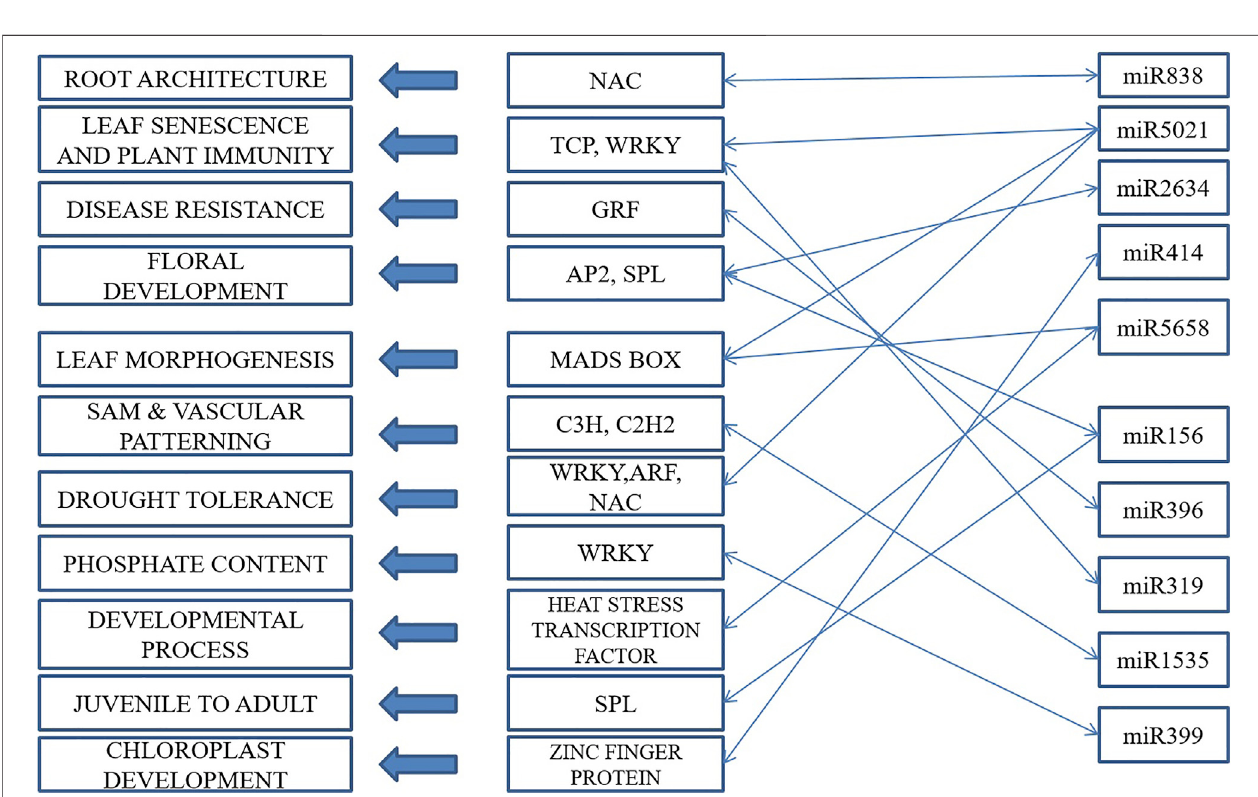
FIGURE 7 | A proposed model of interactions among transcription factors and miRNAs for gene regulation in cluster